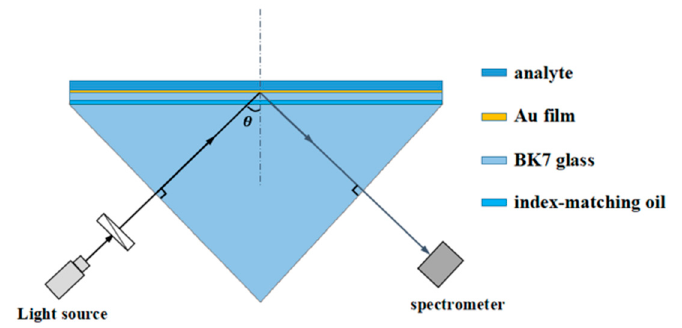
Figure 1. Schematic of the RI sensor based on the AMDW structure.